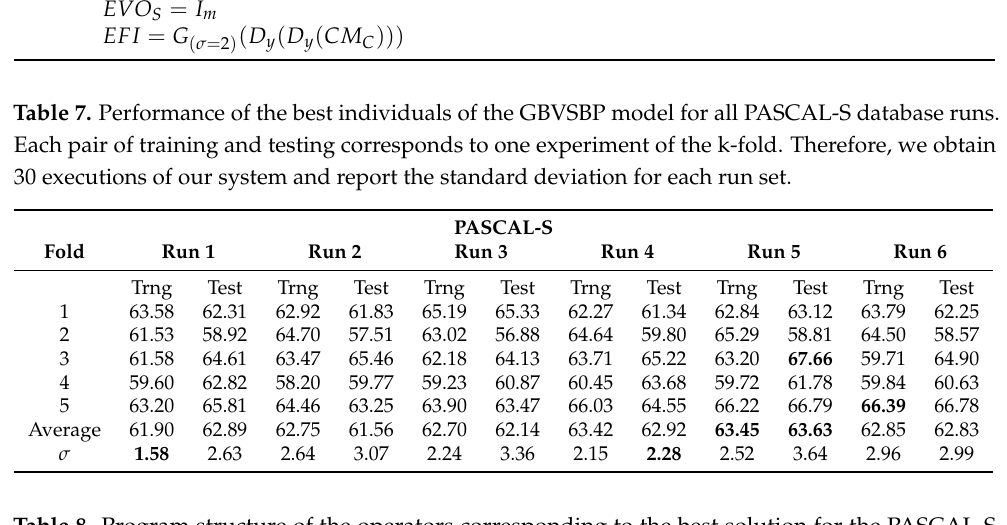
Table 8. Program structure of the operators corresponding to the best solution for the PASCAL-S database. We select this solution from the 30 executions of Table 7. The final solution consists of a combination of different structures. The first visual operator uses a filter and derivative over I s . The second operator uses algebraic operations (addition and subtraction between color bands). The shape dimension uses I m , and the feature integration applies derivatives to the conspicuity map of